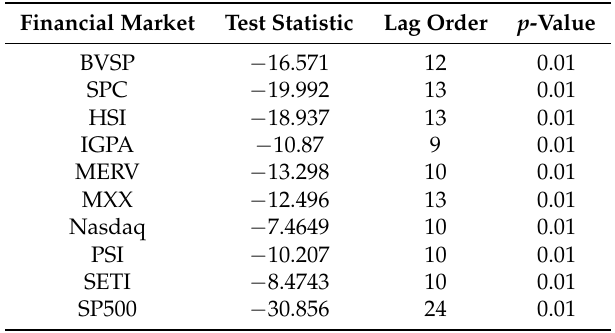
Table 1. ADF test results for returns of various financial markets.